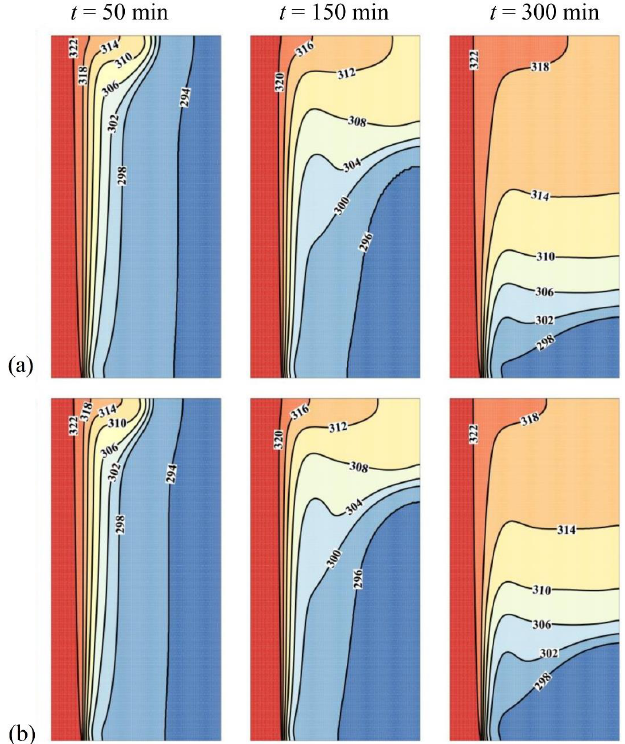
Figure 5. Effect of volume fraction of nanoparticles (ω na ) on the contours of isotherm, ( a ) optimum case with ω na = 0.06; ( b ) Case 1 with ω na = 0 for A = 0 mm. Molecules 2021 , 26 , x